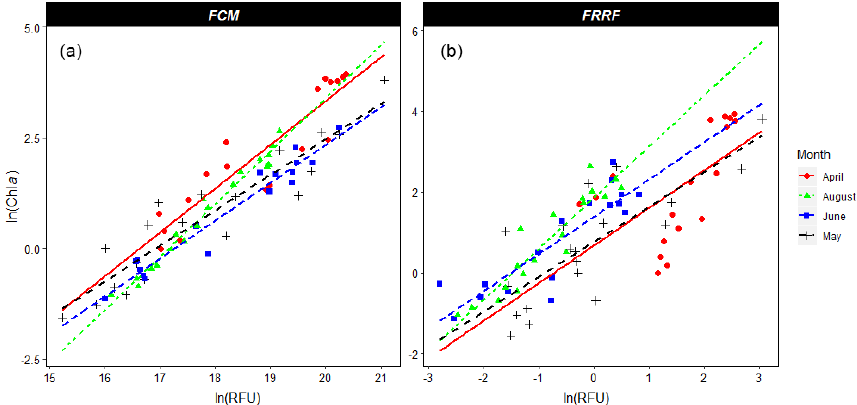
Figure 2. Linear regression of the natural logarithms of Chl a concentration (µgL − 1 ) as determined by HPLC ( y axis); on the x axis is the natural logarithm of FCM-derived total red fluorescence (in relative fluorescence units – RFUs; a ) and FRRf-derived minimum fluorescence ( F 0 in RFUs; b ). Both FCM red fluorescence ( p< 0 . 01, adjusted R 2 = 0 . 90) and the FRRf F 0 ( p< 0 . 01, adjusted R 2 = 0 . 66) are significant predictors for Chl a concentrations. The months (April, May, June, and August) were a significant predictor of Chl a concentration for both the FRRf ( p< 0 . 05) and the FCM ( p< 0 . 01). The interaction between the x and y axis was only significant for the FCM data ( p< 0 . 05). Figure made using the ggplot2 package in R (Wickham, 2009).